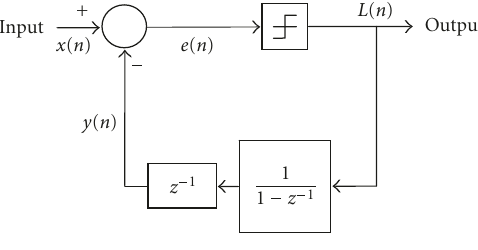
Figure 1: Block diagram of a typical delta